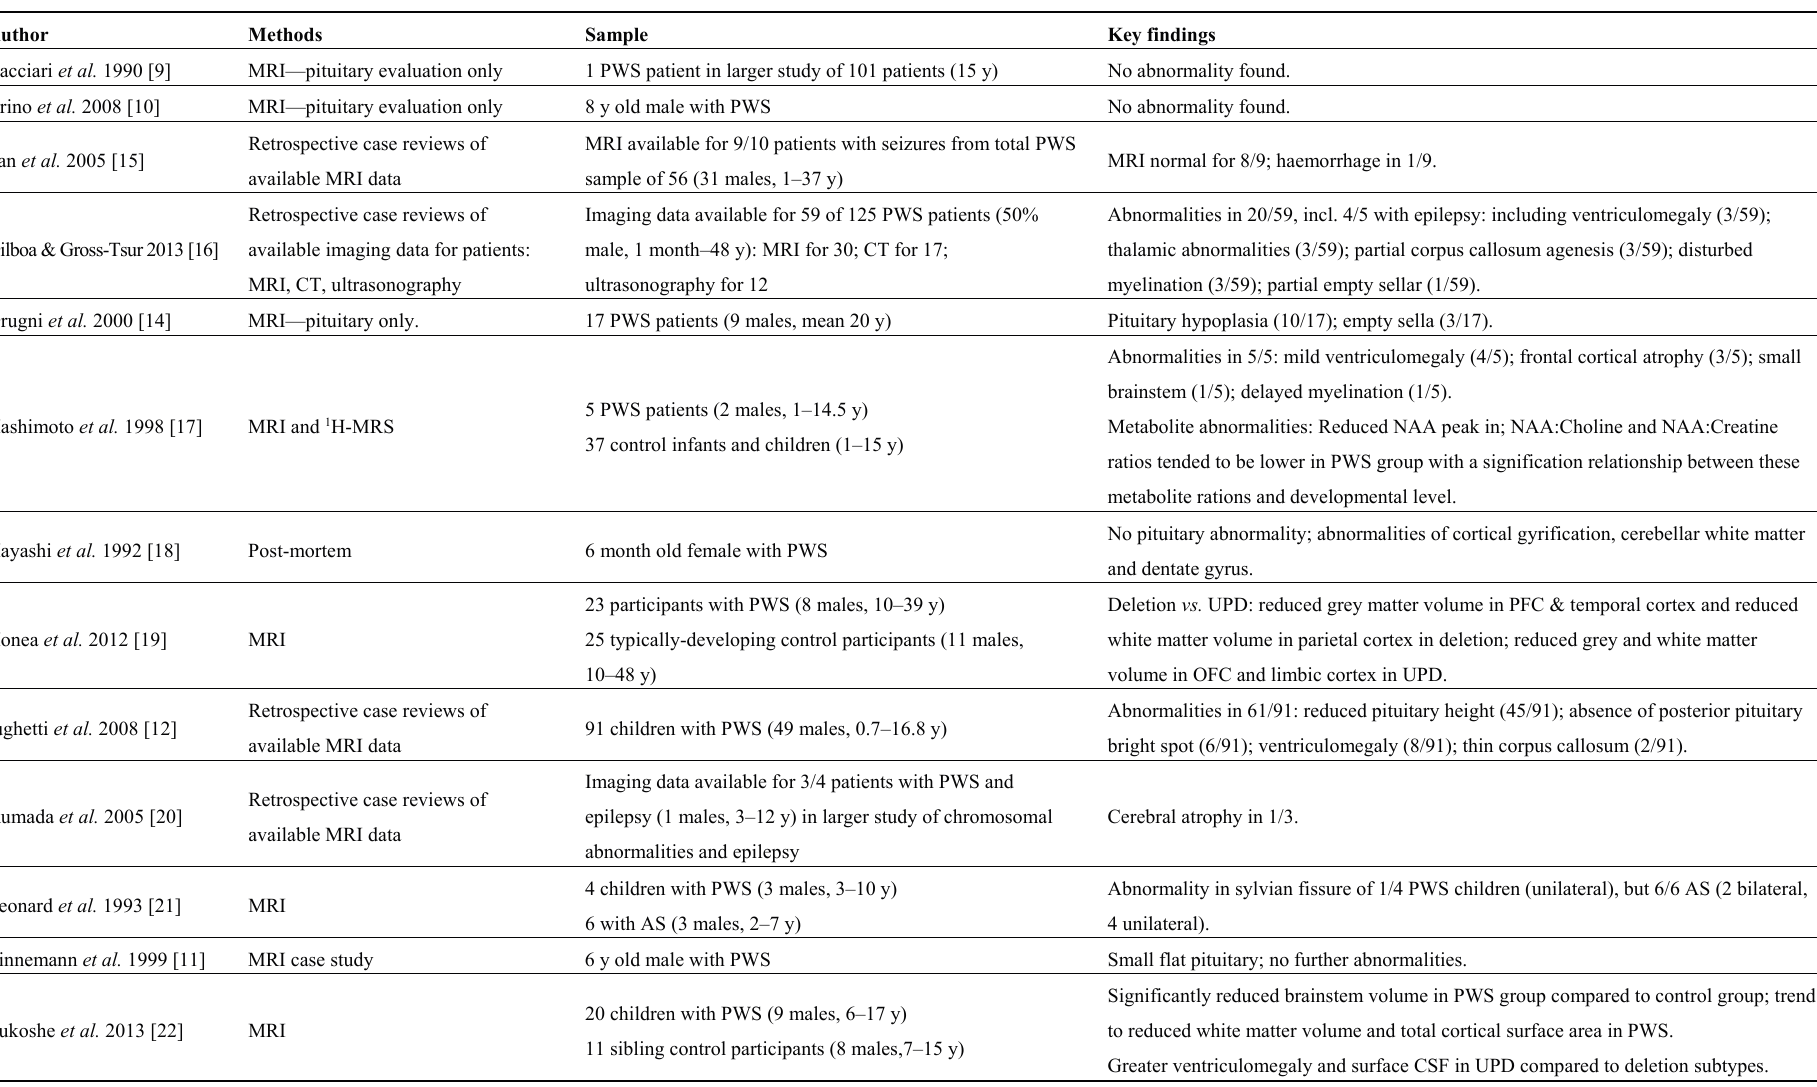
Table 1. Studies reporting macrostructural anatomy in